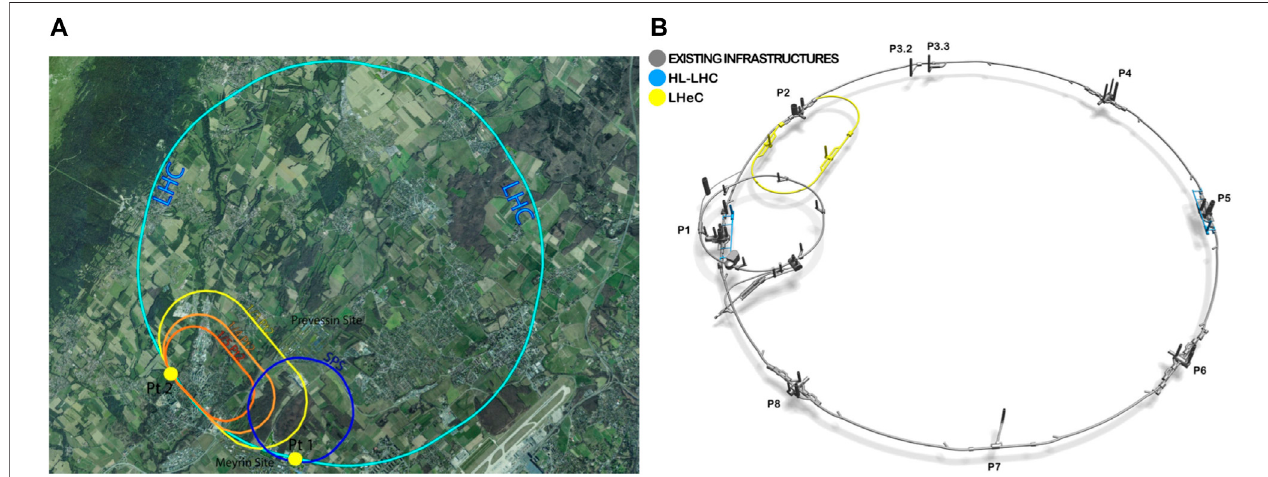
FIGURE2|(A) LayoutoptionsandfootprintoftheLHeCintheGenevabasinnexttotheGenevaairportandCERN.TheyellowracetrackcorrespondstotheLHeC layout that offers optimal performance; in orange, two size variations explored for cost optimization. For reference, the light blue circle depicts the existing tunnel of the LHC; the dark blue circle is the SPS. (B) 3D schematic showing the underground tunnel arrangement. The grey sections indicate the existing SPS and LHC tunnel infrastructures and the yellow section the new LHeC installation.